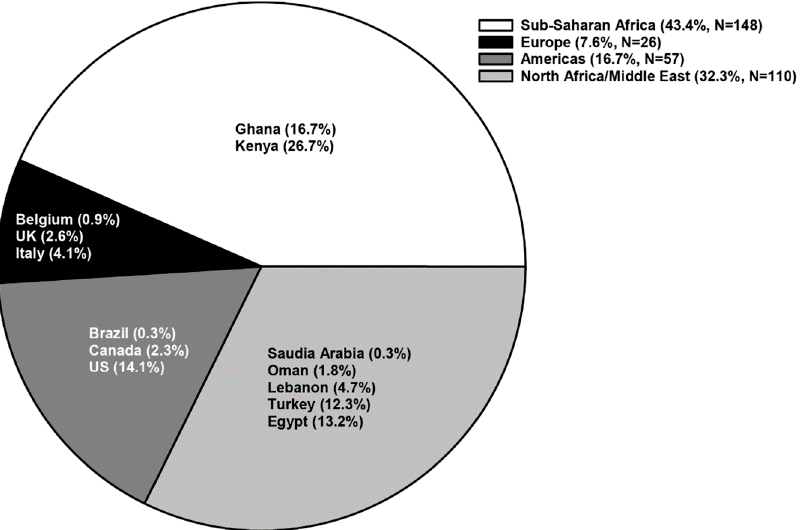
Figure 1. Percent enrollment per region: N, number of randomized subjects; UK, United Kingdom; US, United States.